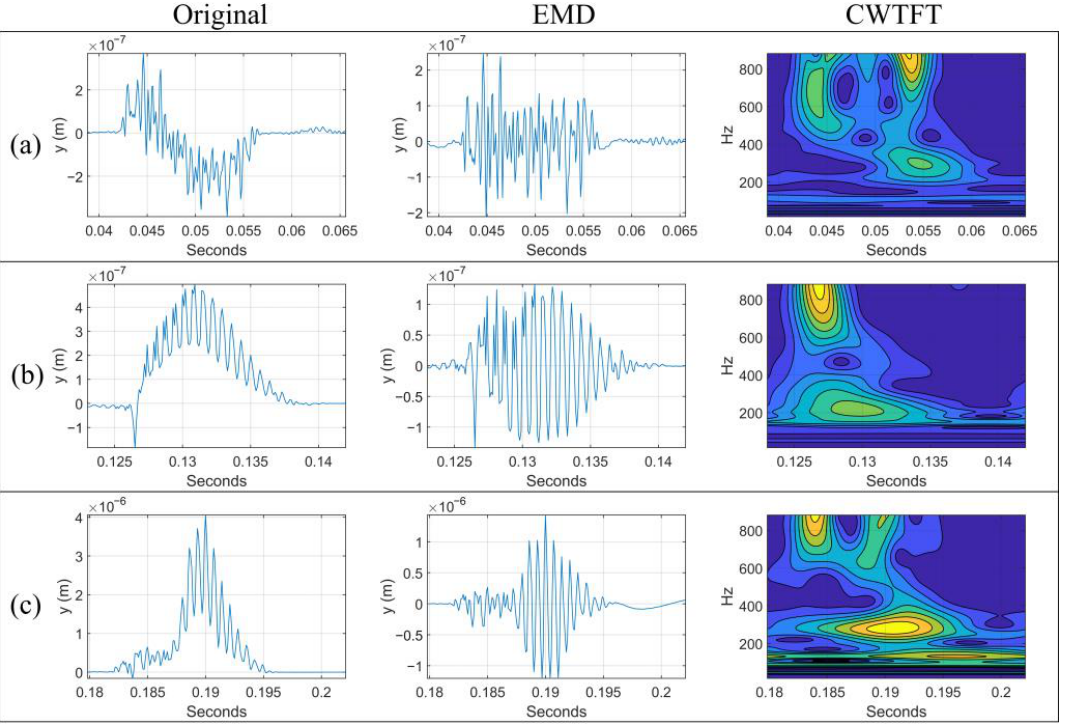
Figure 17. Time and frequency response of the rail in the lateral direction at different locations: ( a ) n 214 , ( b ) n 542 , and ( c ) n 790 . The first two IMFs were chosen. At t = 0.184 s, the node n 790 is subjected to smaller forces than node n 542 and the spectrogram displays a combination of many frequencies, see Figure 17c. The dominant frequency is 290 Hz, in this case. The frequency of 120 Hz is displayed due to the wheel arriving at the sleeper. It is important to see that, unlike longitudinal direction, in the lateral direction the nodes n 542 and n 790 take a moment to react, but this is caused primarily by a larger duration of the peaks in the longitudinal direction, see the differences in Figure 8a,b. The behavior of the rail in the vertical direction at the locations, t = 0.045 s, t = 0.126 s, and t = 0.184 s, are quite different from the longitudinal and lateral directions. High- amplitude forces reduce the appearance of high frequencies; therefore, in order to see the high frequencies in this direction, only the first IMF was selected.